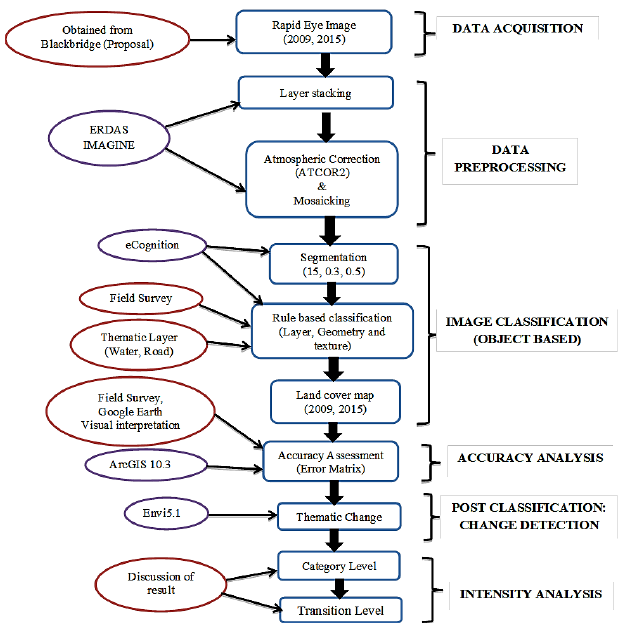
Figure 4. Work flow of the study.